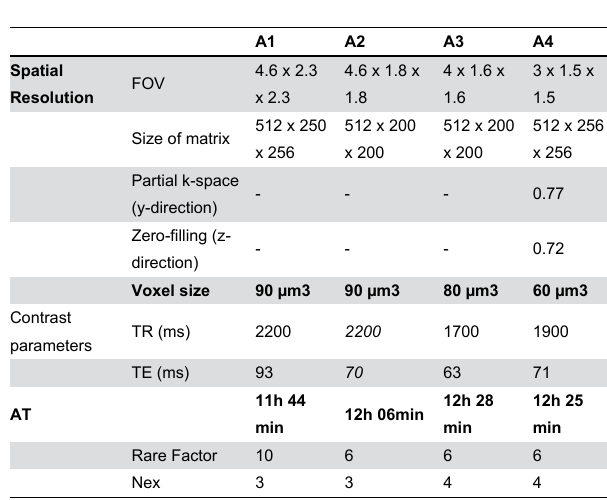
Different sets of MRI parameters (A1 to A4) tested on one unstained rat brain. In bold, the set of parameters chosen for our